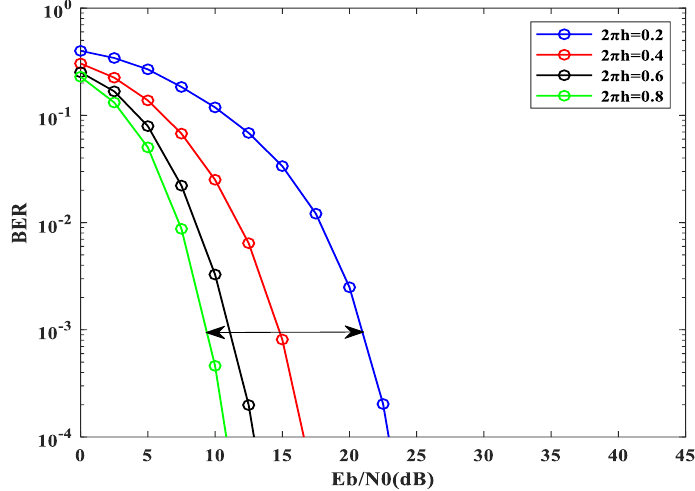
Figure 10. BER versus SNR of PM-OFDM-CDMA (AWGN